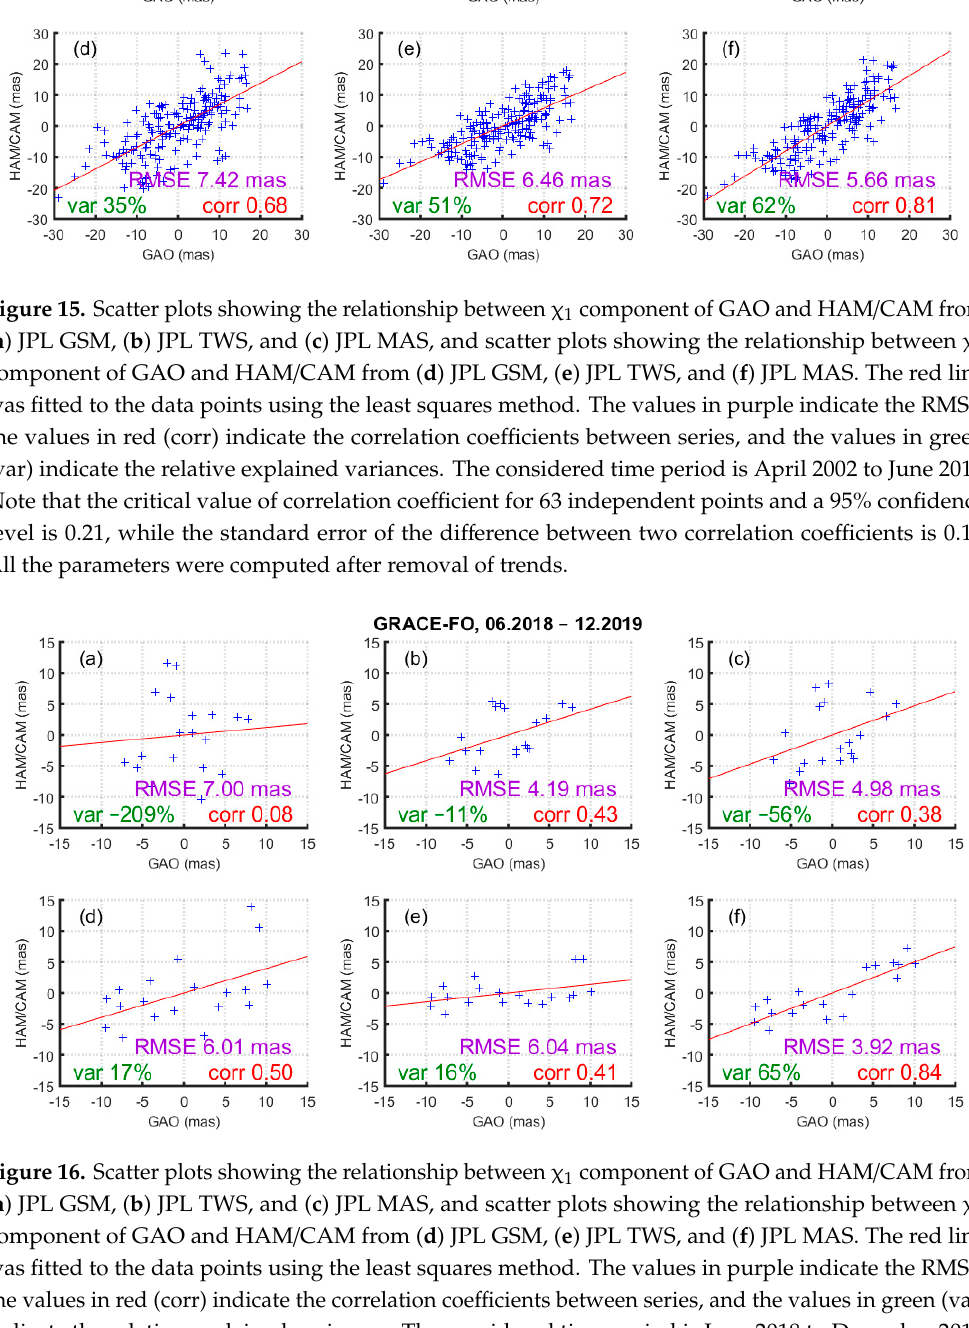
Figure 16. Scatter plots showing the relationship between χ 1 component of GAO and HAM / CAM from ( a ) JPL GSM, ( b ) JPL TWS, and ( c ) JPL MAS, and scatter plots showing the relationship between χ 2 component of GAO and HAM / CAM from ( d ) JPL GSM, ( e ) JPL TWS, and ( f ) JPL MAS. The red line was fitted to the data points using the least squares method. The values in purple indicate the RMSE, the values in red (corr) indicate the correlation coe ffi cients between series, and the values in green (var) indicate the relative explained variances. The considered time period is June 2018 to December 2019. Note that the critical value of correlation coe ffi cient for 12 independent points and a 95% confidence level is 0.50, while the standard error of the di ff erence between two correlation coe ffi cients is 0.47. All the parameters were computed after removal of trends.